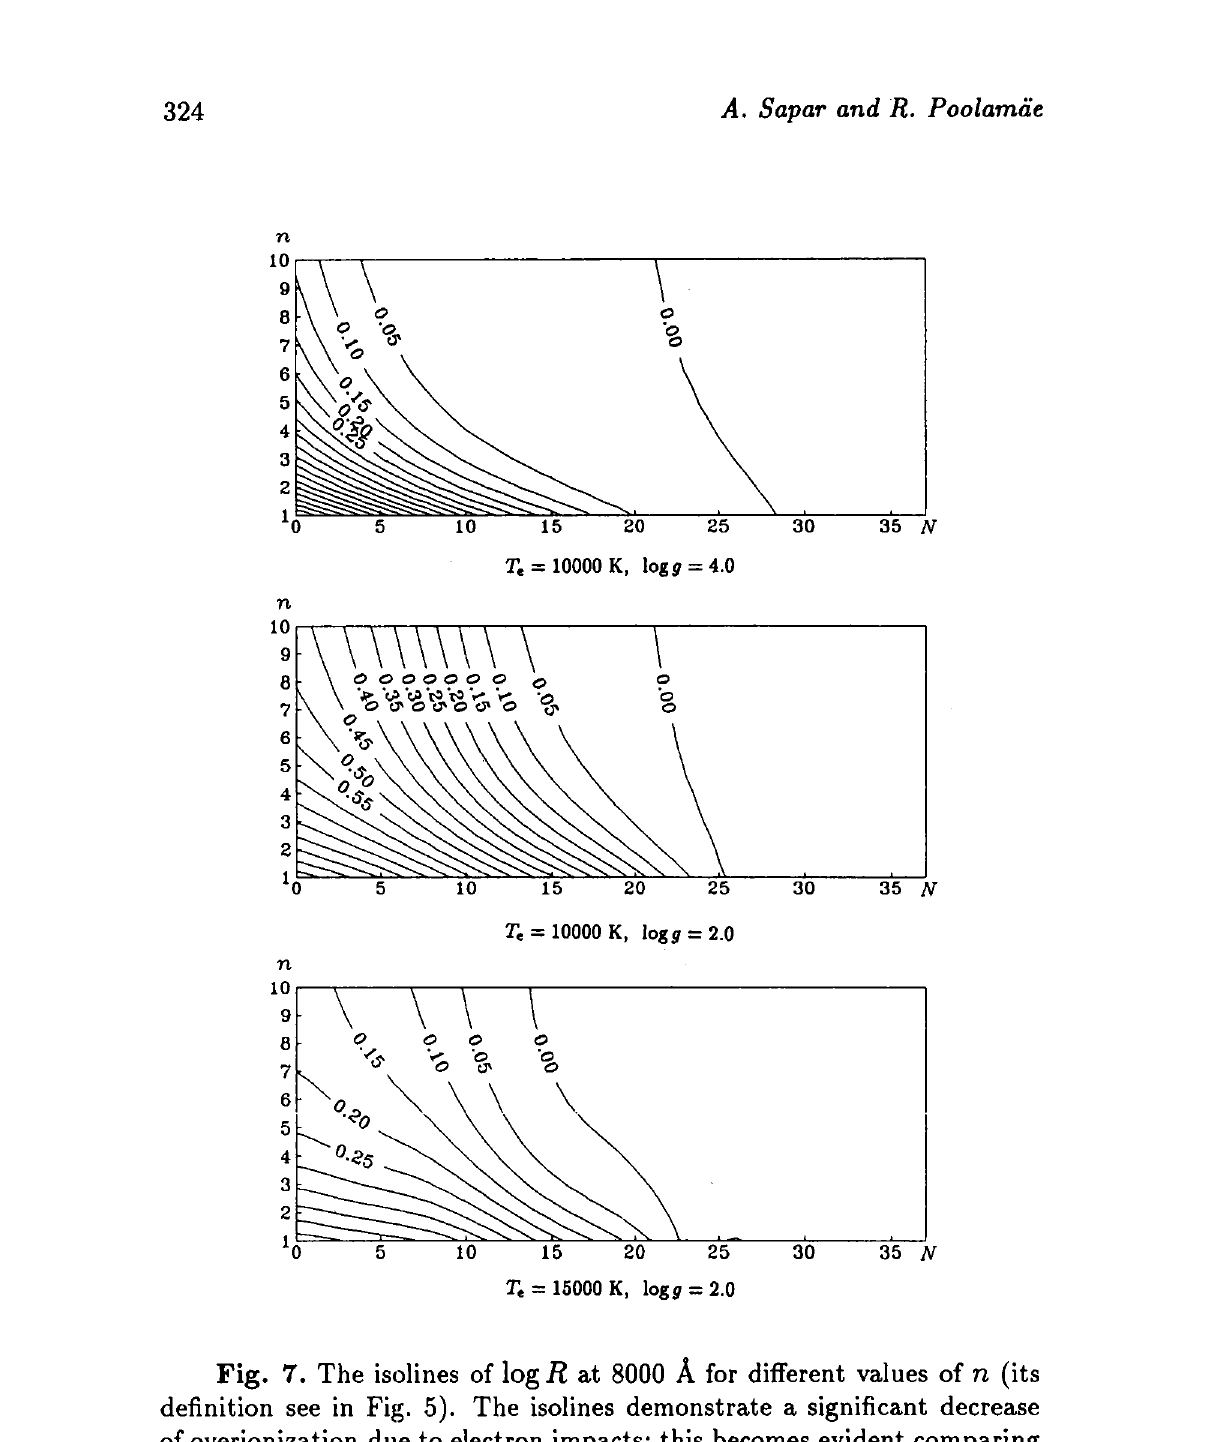
Fig. 7. The isolines of logil at 8000 A for different values of η (its definition see in Fig. 5). The isolines demonstrate a significant decrease of overionization due to electron impacts; this becomes evident comparing the shift of these isolines relative to isolines of log ζ in Fig.